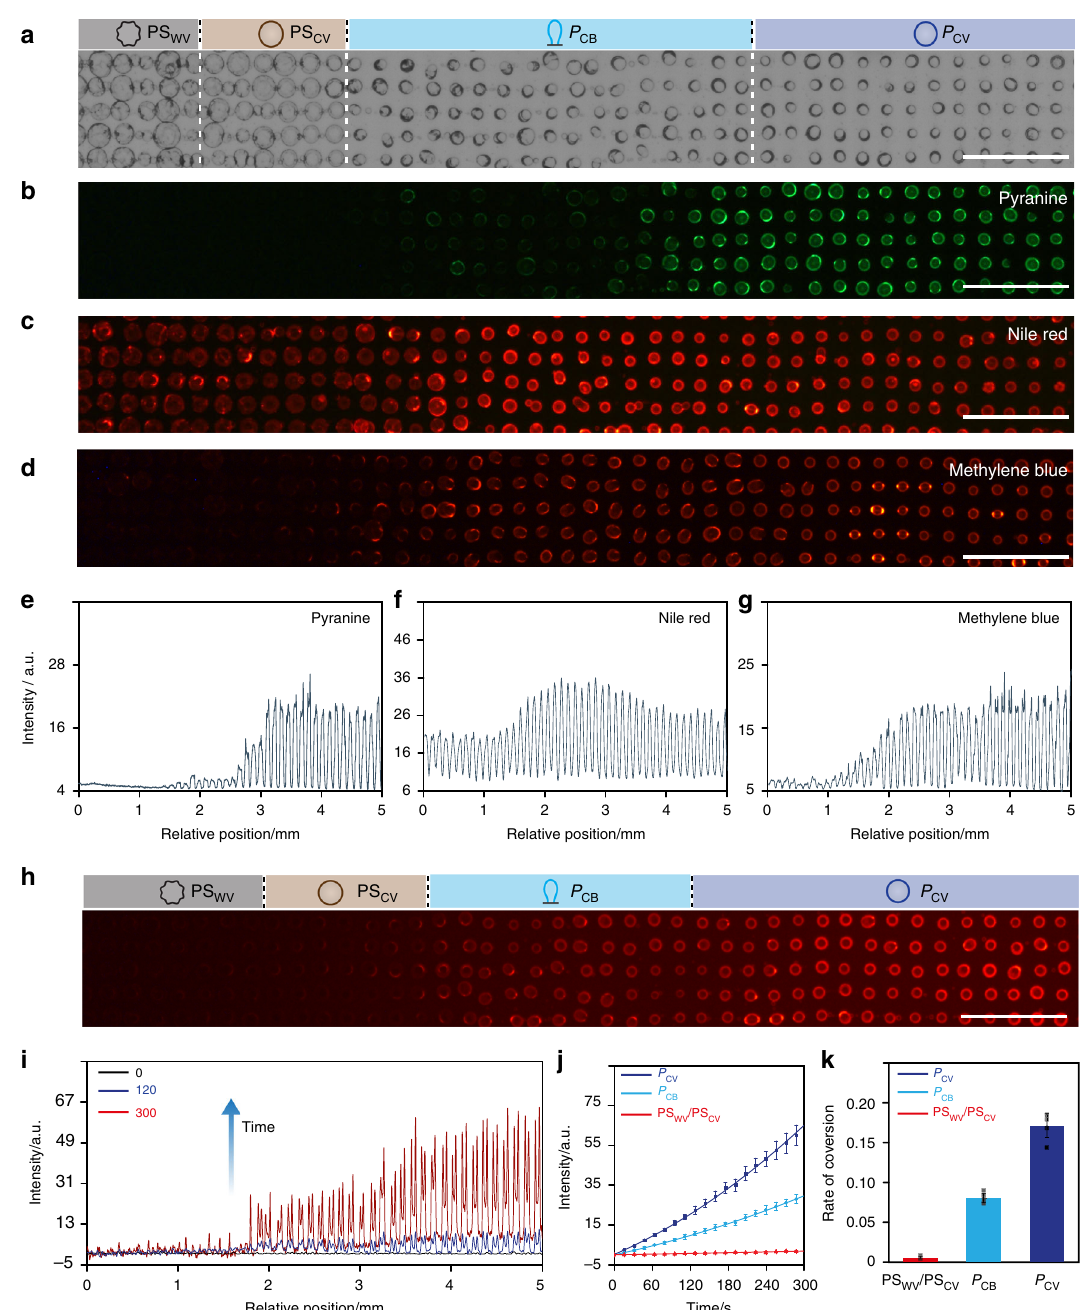
Fig. 5 Functional diversity in differentiated protocell consortia. Representative optical ( a ) and corresponding fl uorescence microscopy ( b – d ) images of 2D arrays of differentiated coacervate droplets comprising a spatially separated tetra-modal distribution of PS WV , PS CV , P CB and P CV (from left to right, see graphics) morphological forms after exposure to aqueous solutions of pyranine (negatively charged, b) , Nile Red (neutral, c ) or methylene blue (positively charged, d) ; scale bars, 500 µ m. e – g Average fl uorescence line intensity pro fi les recorded across the tetra-modal populations (spatial distribution) shown in b , c , d ; a.u. arbitrary units. h Fluorescence microscopy image of a 2D array of HRP-containing differentiated protocells comprising a spatially separated tetra-modal distribution of PS WV , PS CV , P CB and P CV (from left to right, see graphics) morphological forms. The image is recorded 300 s after injection of a mixture of Amplex red and H 2 O 2 across the 2D array; scale bar, 500 µ m. i Average fl uorescence line intensity pro fi les recorded across the tetra-modal population distribution shown in h at 0 (black line), 120 (blue) and 300 s (red) after addition of Amplex red and H 2 O 2 . j Plots of time-dependent changes in resoru fi n fl uorescence mean intensity associated with individual HRP-containing PS WV and PS CV (red), P CB (light blue) and P CV (dark blue) types showing different rates of enzyme activity across the differentiated community. k Plots of the initial rates of HRP-mediated conversion of Amplex red to resoru fi n for data in j . Data recorded over the fi rst 200 s; rate of conversion displayed as arbitrary units per second. The tetra-modal populations were prepared in opposing morphogen gradients (SDS, left side), POM (right side) at an initial SDS : POM molar ratio of 2.3 (70/30 µ L; 50 mM). Source data are provided as a Source Data fi le. Error bars represent the standard deviation of the substrate conversion ( n =